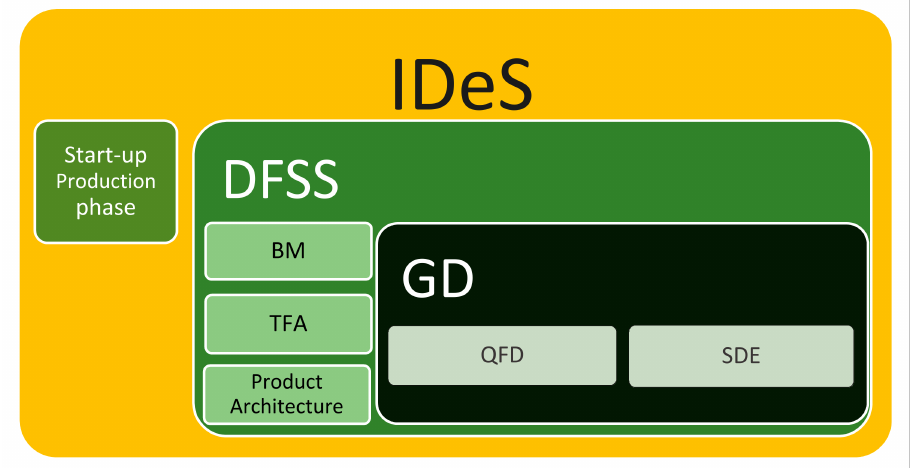
Figure 1. IDeS methodology embraces other product design methods and includes initial production